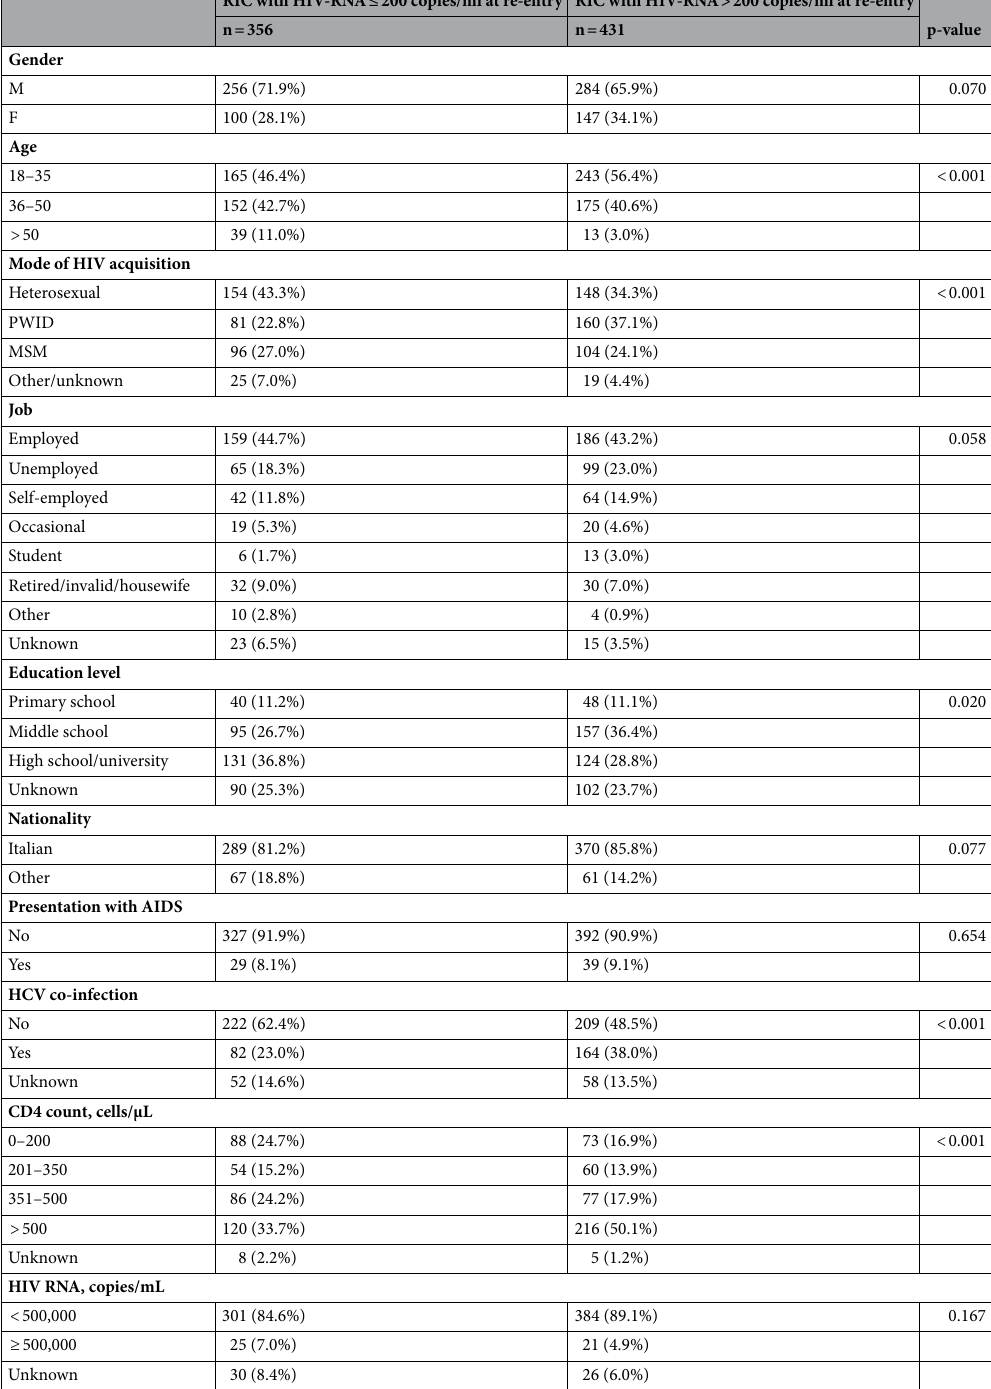
Table 3. Comparison of main characteristics at the enrolment between RIC patients according to the level of HIV-RNA at the